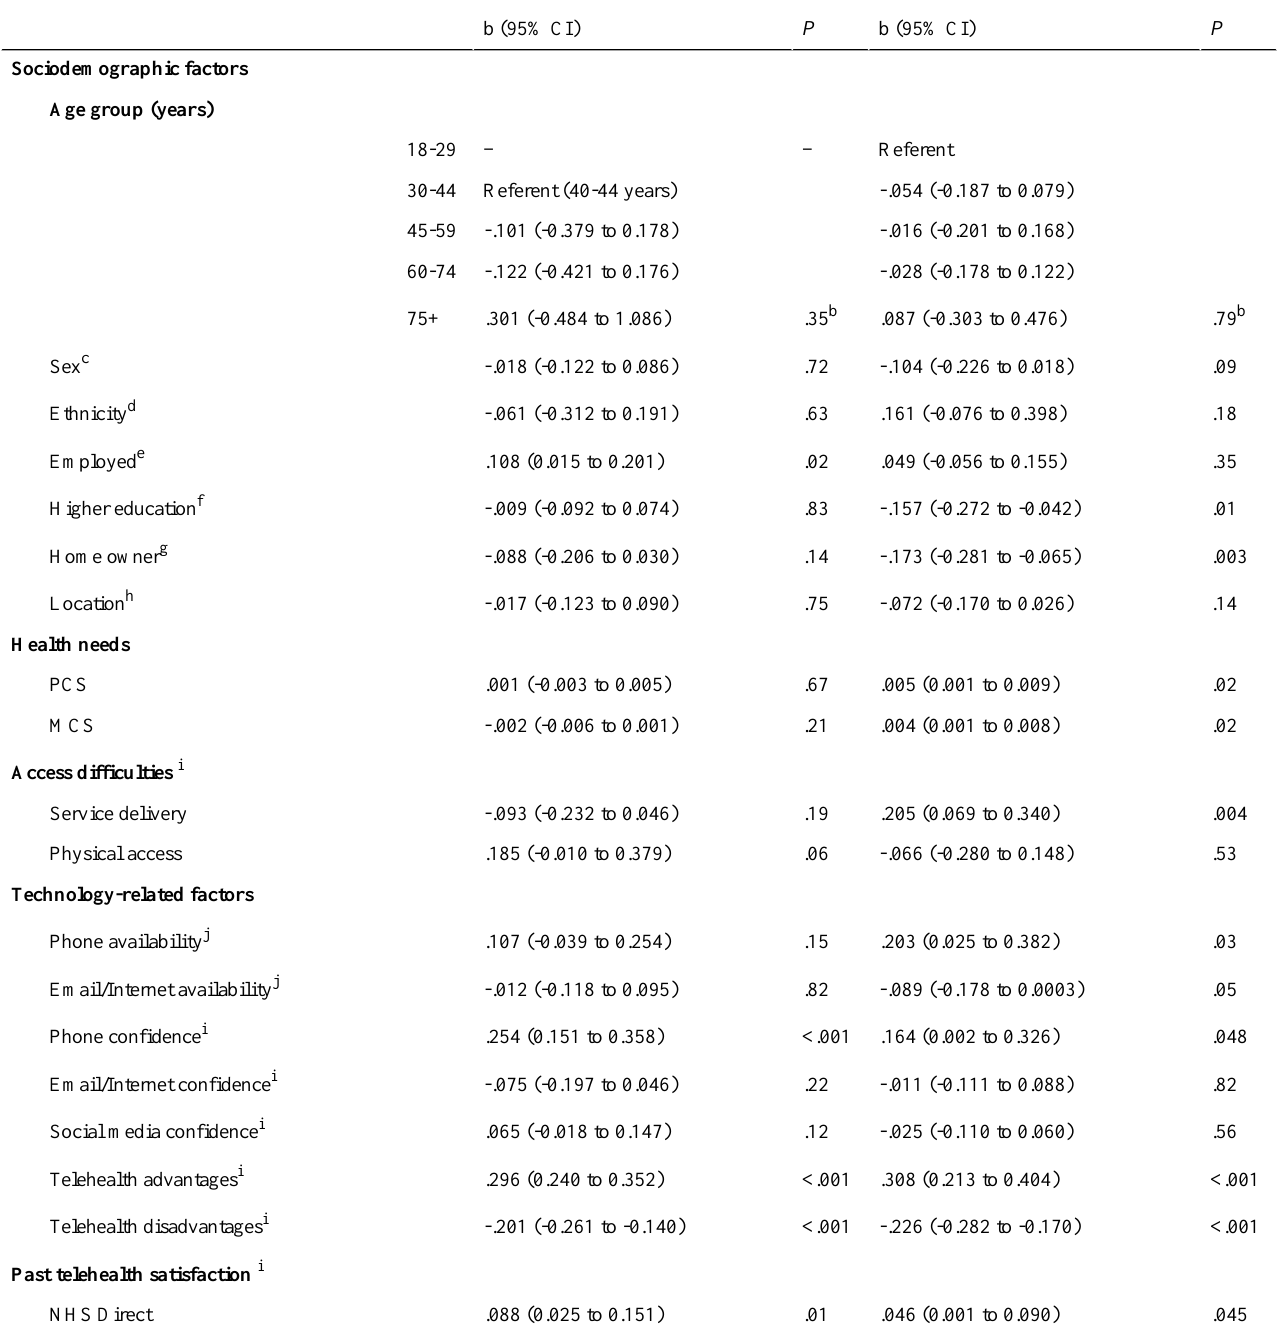
Table 4. Multivariable analysis of factors associated with interest in phone-based telehealth a